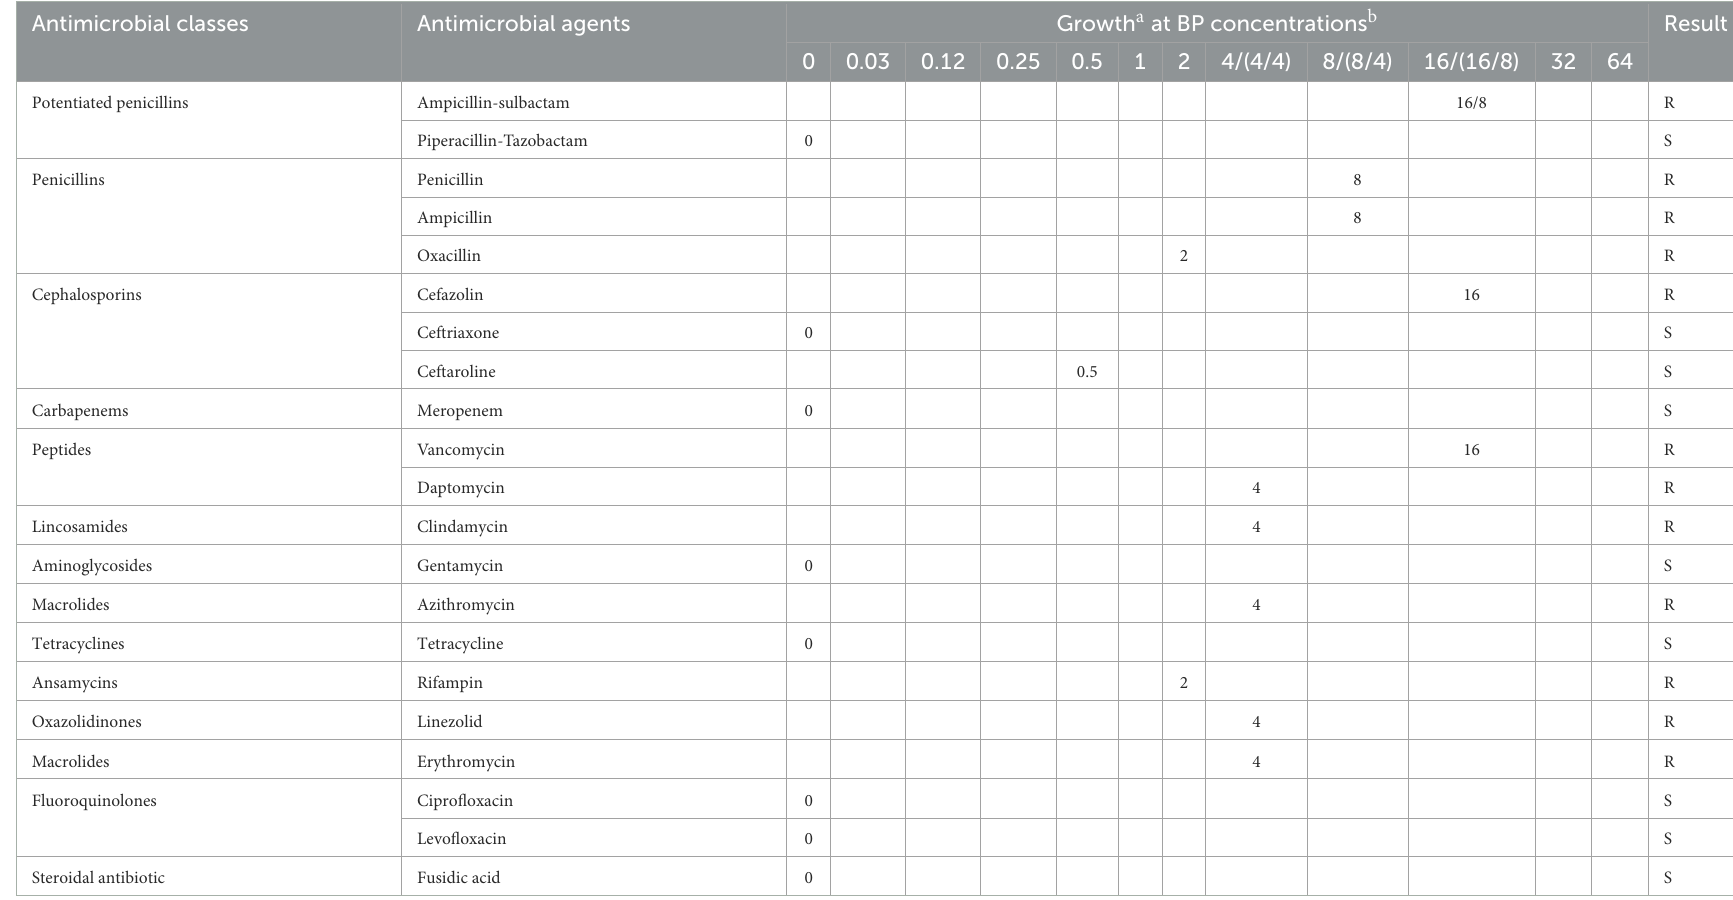
TABLE 2 Beckman Coulter microplate breakpoint